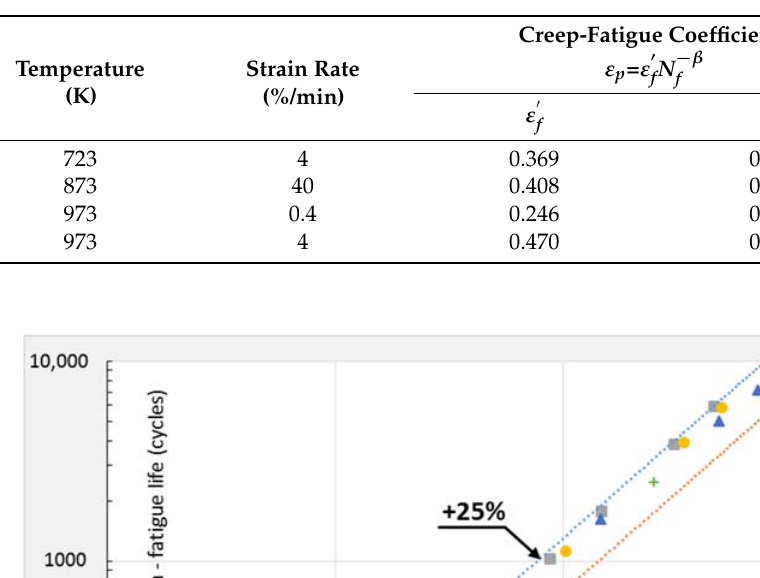
Table 6. Creep-fatigue data for stainless steel 316.